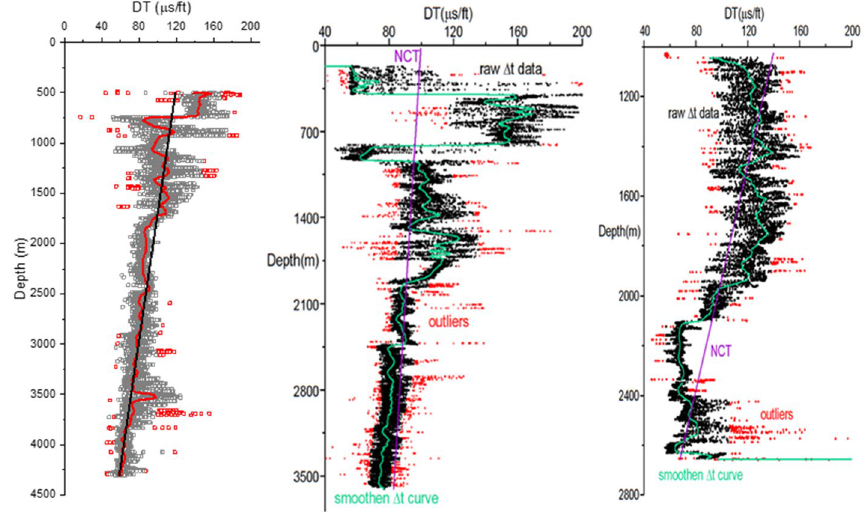
Figure 9. Smoothened ∆t vs. depth curve and NCT plot for well # 01, 27, and 30,